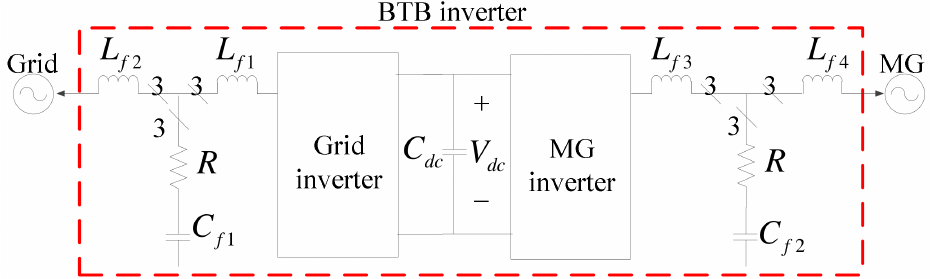
Figure 3. The circuit configuration of the proposed BTB inverter-based SS.